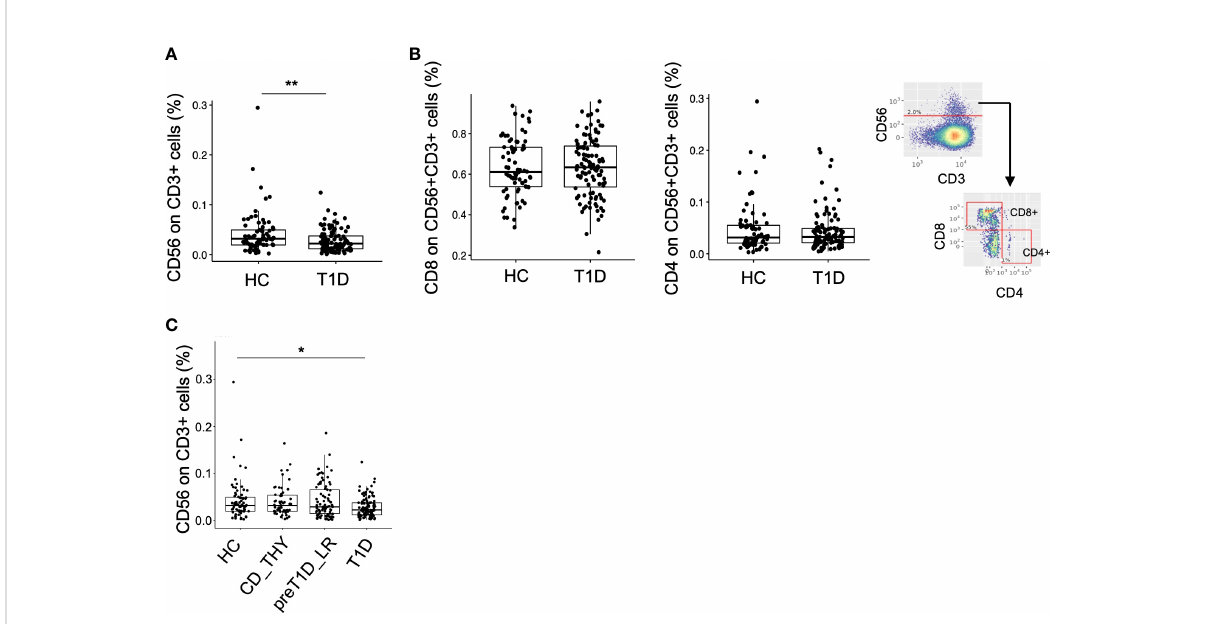
FIGURE 4 Validation of the TR3-56 cell biomarker in our cohort. Frequency of CD56 + CD3 + cells (namely T R3-56 cells) in HC and T1D using the semi- automated gating strategy (A) . Frequency of CD8 and CD4 on TR 3-56 cells and representative semi-automated gating strategy employed for the analysis. (B) . Frequency of T R3-56 cells in HC, CD_THY, preT1D_LR and T1D (C) . Signi fi cant differences were determined by Student ’ s t-test for pairwise comparisons and by Tukey post-hoc test on the linear regression model for multiple comparisons (*p < 0.05, **p <